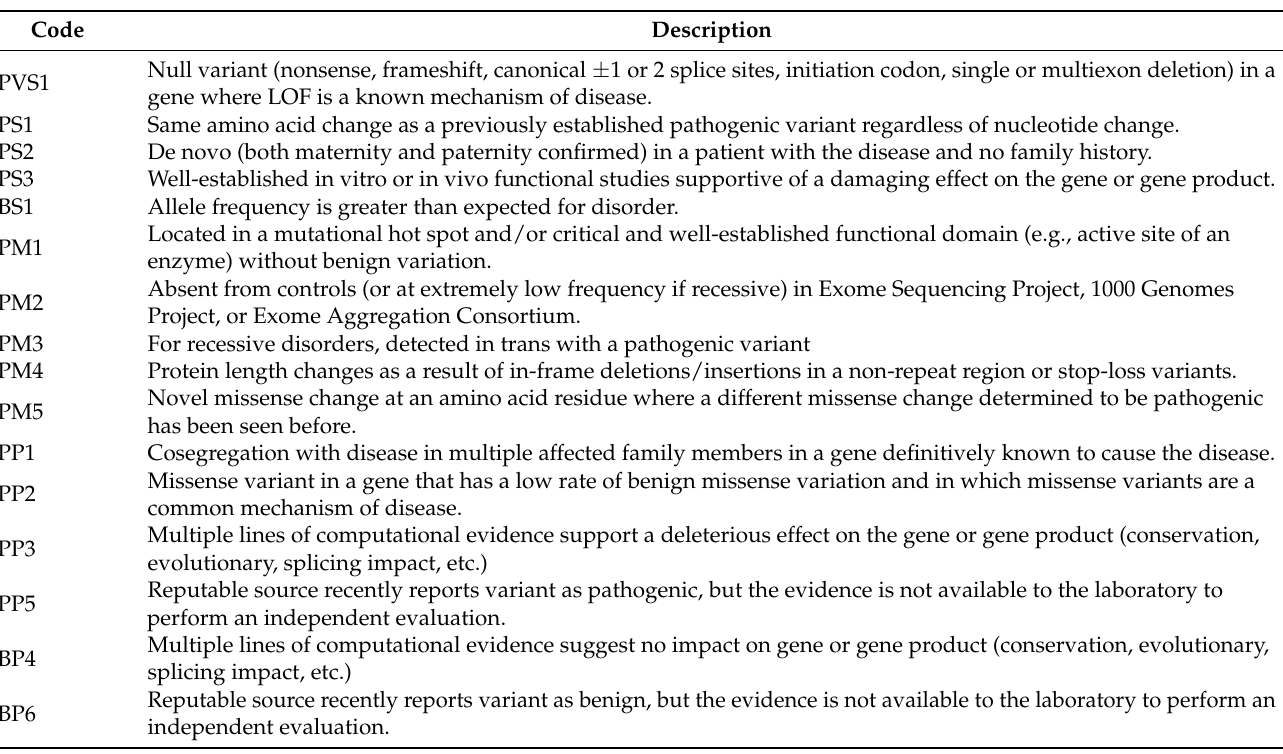
Table A2. American College of Medical Genetics and Genomics criteria.